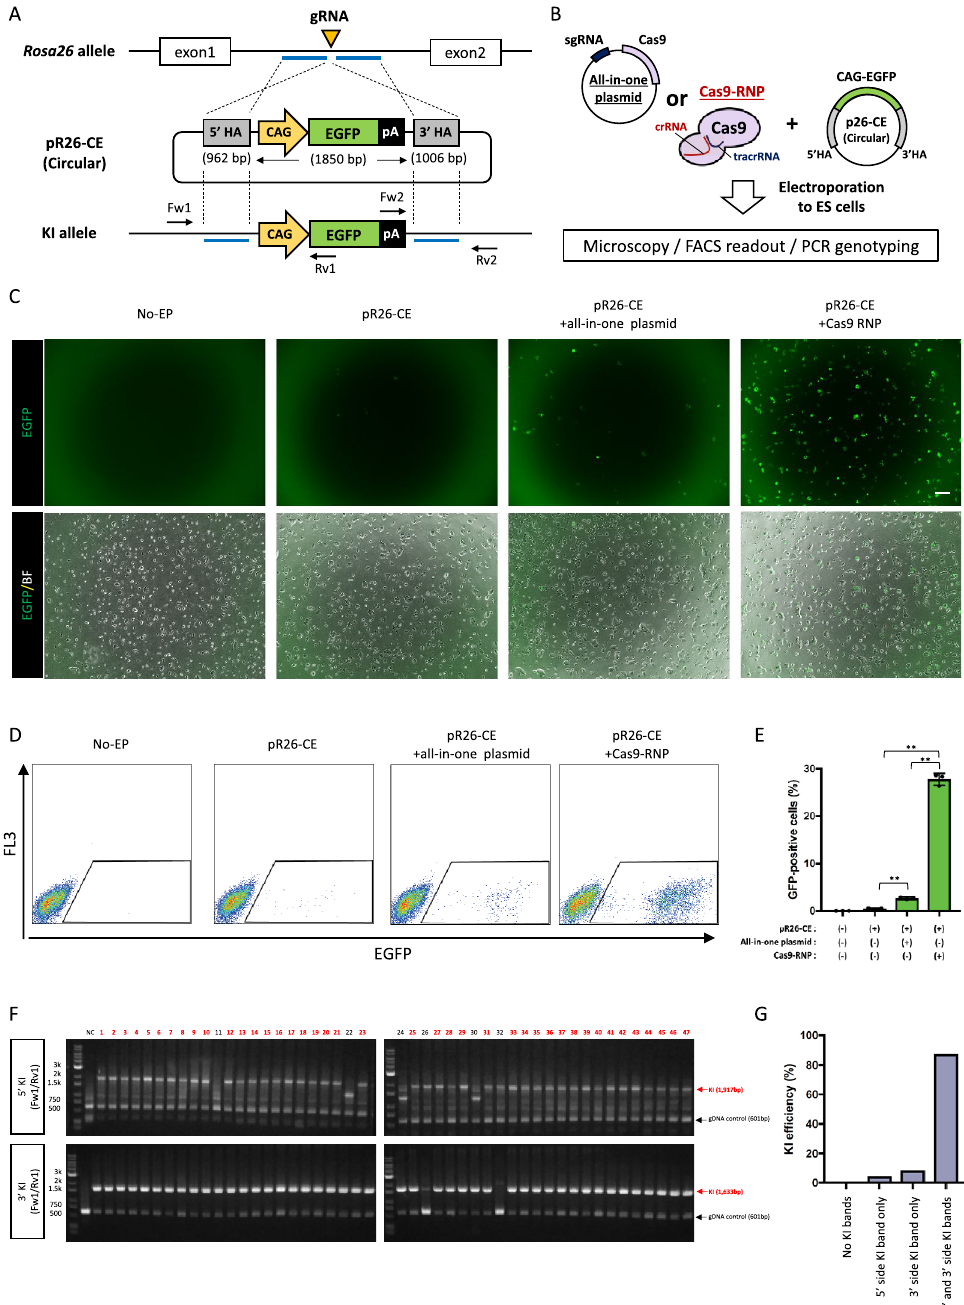
Figure 1. CRISPR/Cas9 ribonucleoprotein (RNP)-mediated circular plasmid integration into ES cell genome is highly locus-specific. ( A , B ) Schematic representations of circular plasmid introduction strategies. Linearized vector containing CAG-EGFP cassette flanked by approximately 1 kbp next to the gRNA target was transduced into ES cells via electroporation ( A ). Circular plasmid as a targeting vector was introduced into ES cells with CRISPR/Cas9 expression vector (left) or CRISPR/Cas9 ribonucleoprotein (RNP, right) by single electroporation ( B ). ( C ) Representative ES cell colonies under a fluorescent microscope. Top panels show EGFP images and bottom panels show merged images of EGFP and bright field. Left: no electroporation (No-EP); middle-left: transduction of targeting vector-only; middle-right: transduction of targeting vector with CRISPR/Cas9 all-in-one plasmid; right: transduction of targeting vector with CRISPR/Cas9 RNP. Scale bar, 50 µm. ( D ) Flow cytometry of ES cells. Gate represents EGFP-positive fraction. ( E ) EGFP-positive cell ratios are shown as mean ± SEM. The asterisk depicts a significant difference (n = 3, P < 0.01). ( F , G ) Genomic PCR analyses of EGFP-positive ES cell clones collected via flow cytometry. Gel images or KI ratios are shown in F or G, respectively. Red arrows in the upper or bottom panels indicate the 5 ′ or 3 ′ Rosa26 KIs, respectively, and black arrows indicate genomic DNA (gDNA) PCR control. Both 5 ′ and 3 ′ PCR positive clones are indicated with red numbers. NC negative control using genomic DNA from wild-type B6 mouse